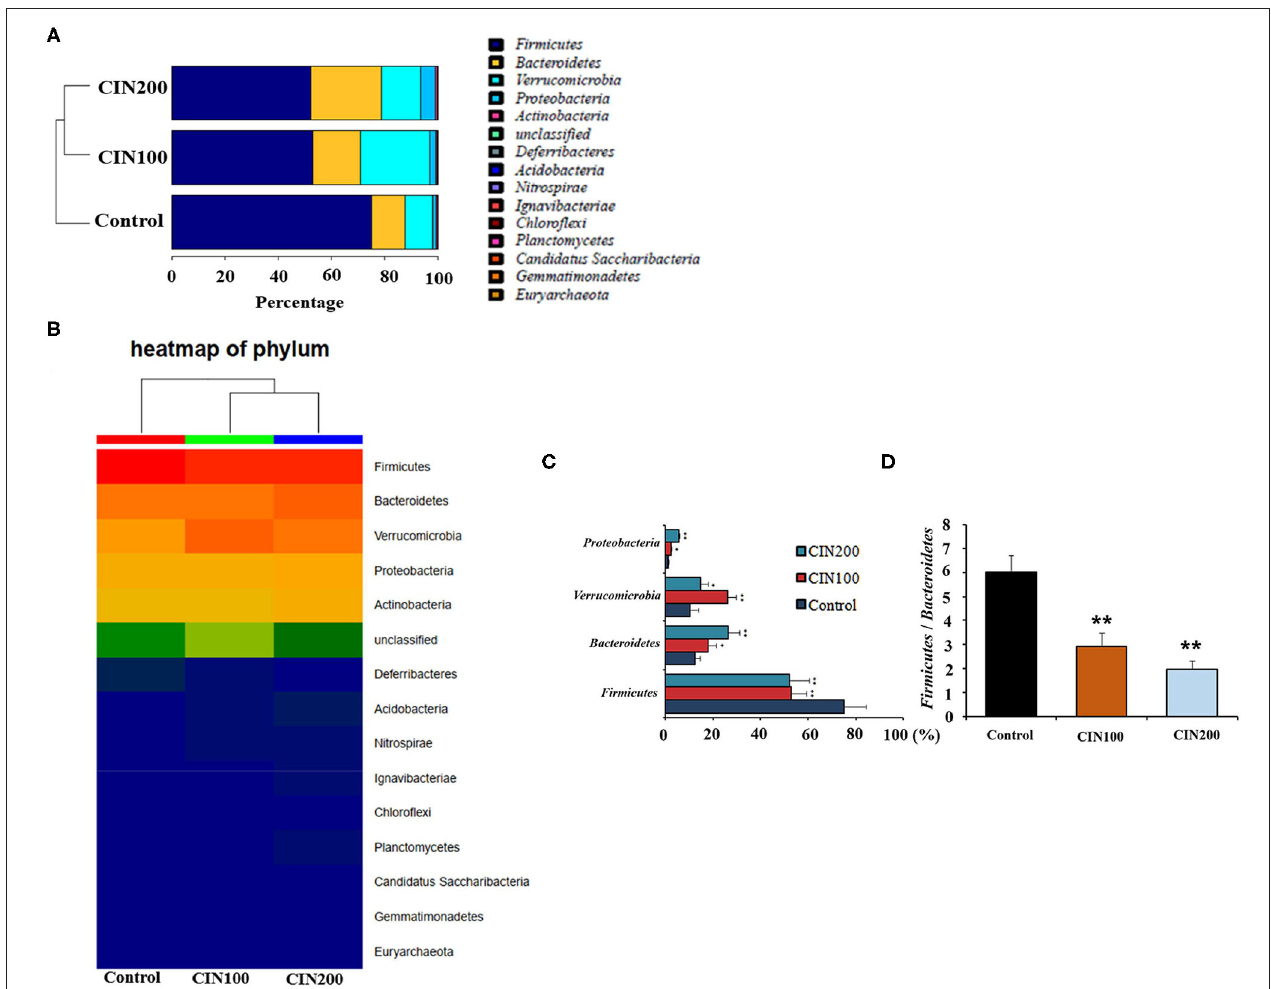
FIGURE 6 | Cinnamaldehyde supplementation remodels the structure of gut microbiota in early weaned rats. (A) Composition of gut microbiota at the phylum level analysis. (B) Heat map of phylum. (C) Relative abundance of the top four phyla. (D) Ratio of Firmicutes to Bacteroidetes . Data are presented as mean ± SEM. * P < 0.05 and ** P < 0.01. One-way ANOVA was carried out for each comparison with HSD